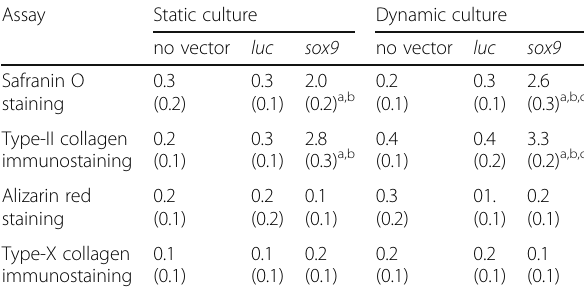
Table 5 Histomorphometric analyses in the rAAV-transduced human bone marrow aspirates (day 7)